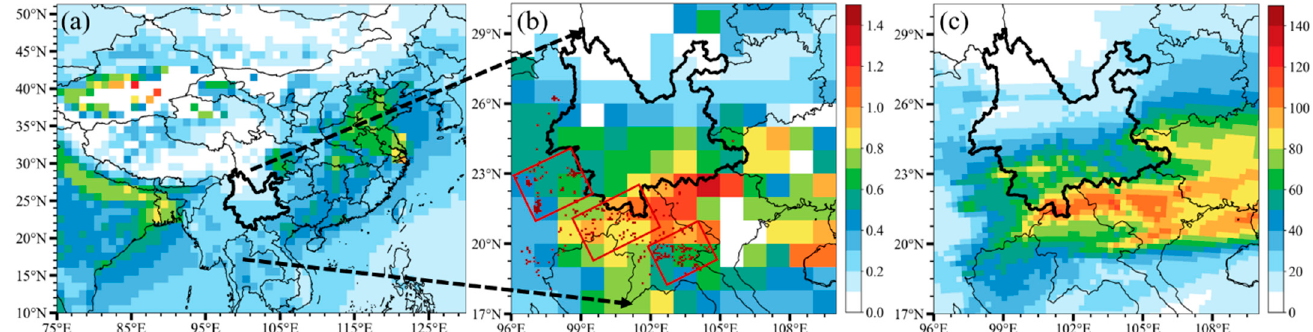
Figure 3. ( a ) Spatial distribution of the monthly mean of MODIS AOD in 2017 over East and Southeast Asia. ( b ) Spatial distribution of the daily mean of MODIS AOD and BB PM 2.5 emissions from FINN (red dots, emission rate > 3.5 µg m − 3 s − 1 ) during 24–26 March 2017 over Southeast Asia, with the main BB emission sources marked in red rectangles and YP outlined with a bold black line. ( c ) Spatial distribution of the hourly mean of PM 2.5 concentrations (µg m − 3 ) modeled from 24 to 26 March 2017 over YP and its surrounding areas; the PM 2.5 concentrations were obtained by vertical integration from 700 hPa upwards.